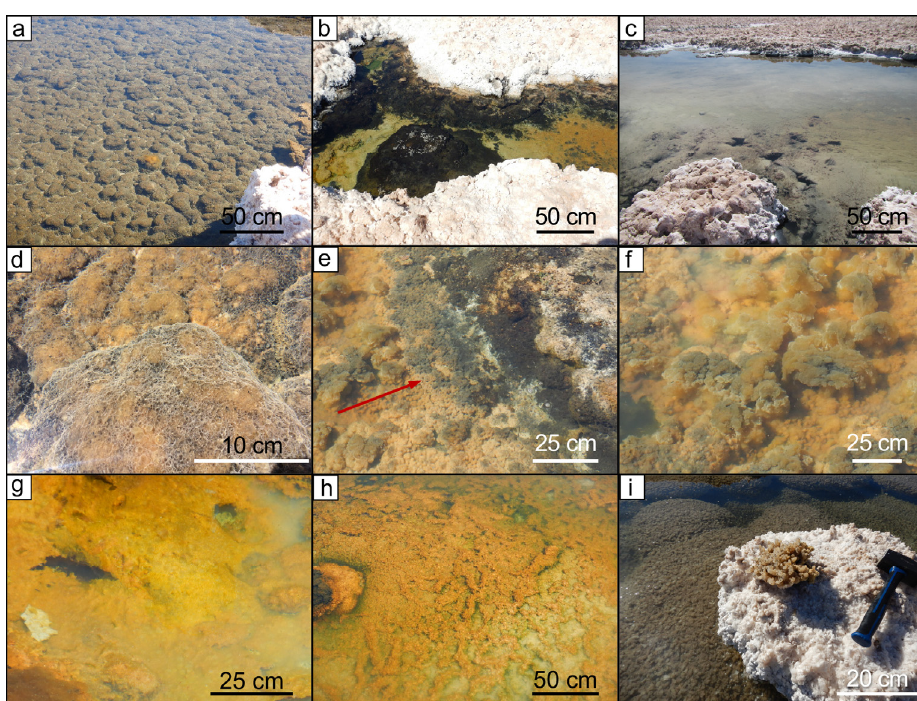
Figure 2. Field photos showing the main bottom types during March 2019 in the Puquio 1 and Pu- quios 2 system including ( a ) black domes, ( b ) black semi-cohesive mat, ( c ) floccules, ( d ) network on bulbous mat, ( e ) carpet (arrow pointing to the carpet bottom type), ( f ) orange–brown bulbous, ( g ) orange gel mat, ( h ) orange gel mat with black pinnacles, and ( i )